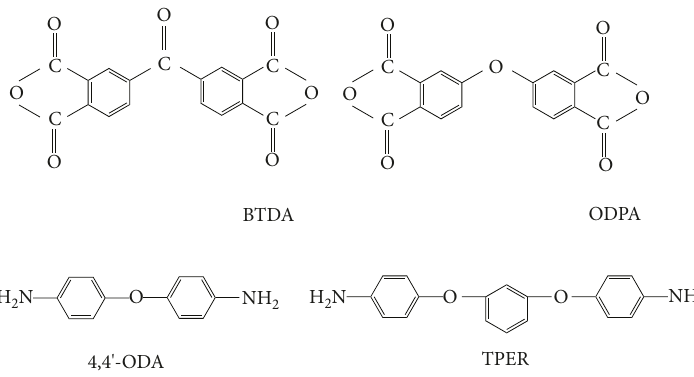
Figure 1: Chemical structure of monomers used for polyimide synthesis.